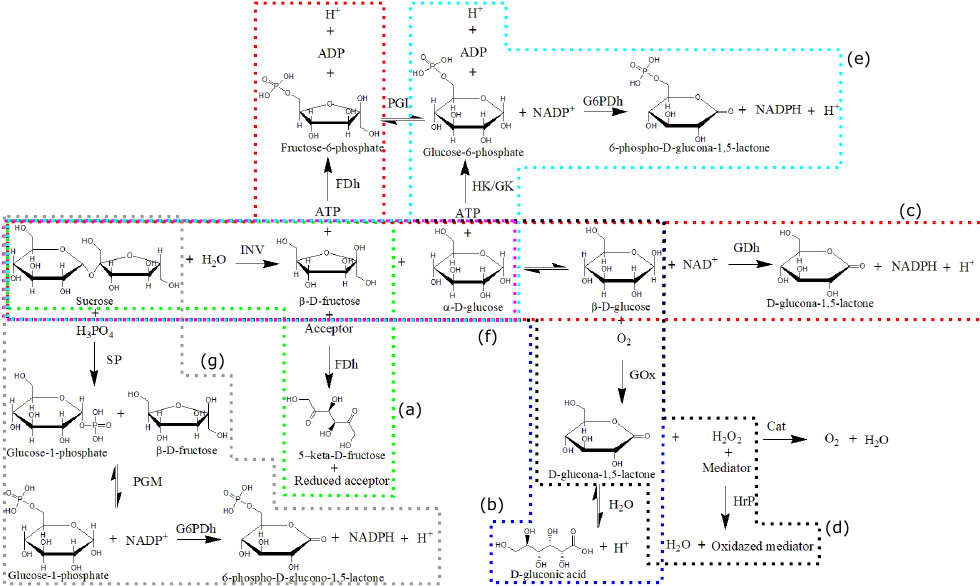
Figure 3. Sequence of enzymes for cascade reactions in enzymatic biosensing of